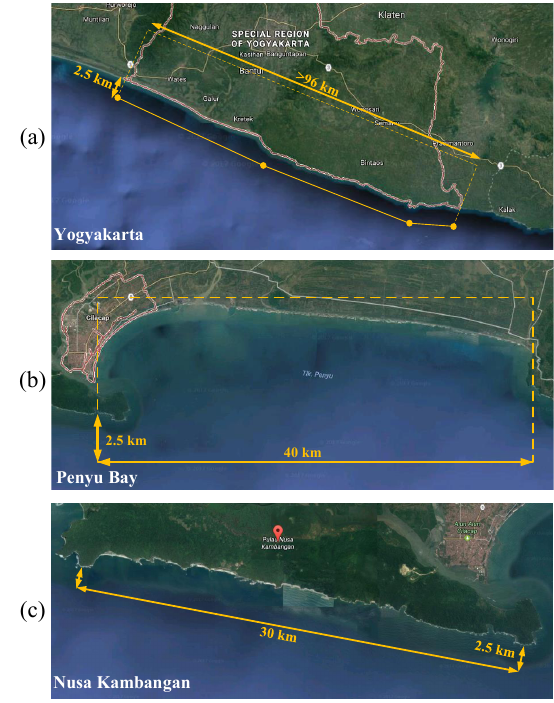
Figure 7. Map of Yogyakarta ( a ), Penyu Bay ( b ), and Nusa Kambangan ( c )